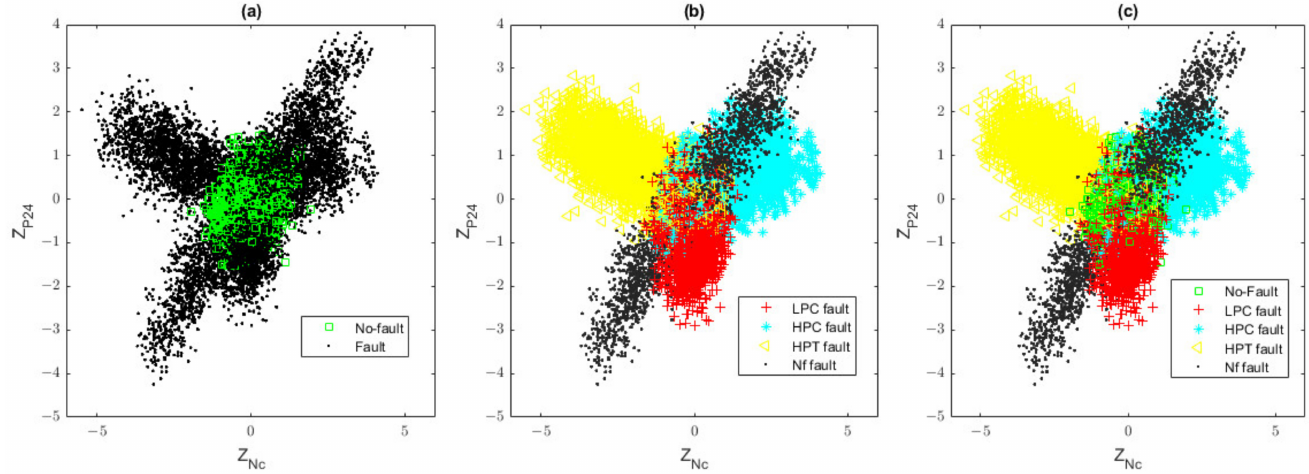
Figure 5. Recognition problem using feature vectors for ( a ) anomaly detection stage, ( b ) fault identification stage, and ( c ) both stages as a common